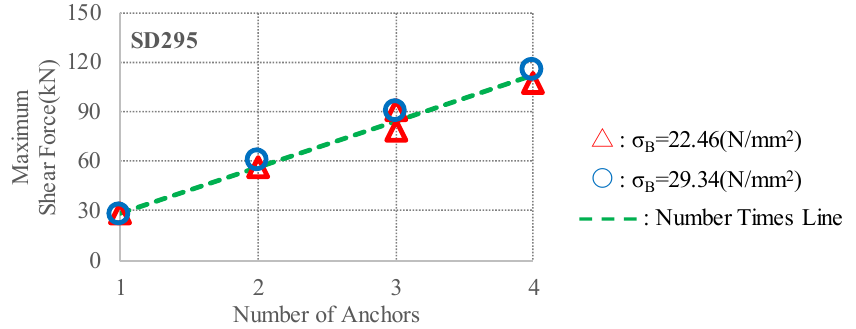
Figure 5. Maximum shear force-number of anchors relations.